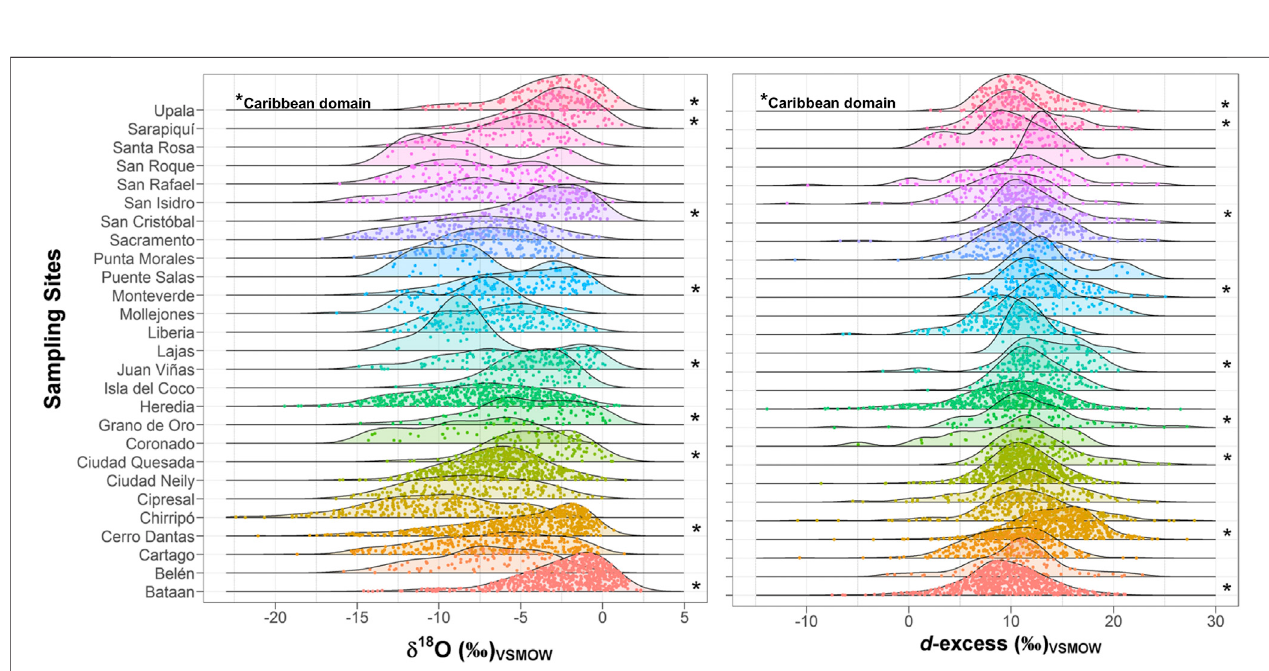
FIGURE5 | Samplingsites isotope variability. Density distribution of δ 18 O ( ‰ ) (left) and d -excess ( ‰ ) (right) across 27monitoringstations inCosta Rica from 2013 to 2019 (N (cid:2) 5,905). Asterisks denote stations located across the Caribbean slope. Figure adapted using data from Sánchez-Murillo and Birkel (2016) and Sánchez- Murillo et al.